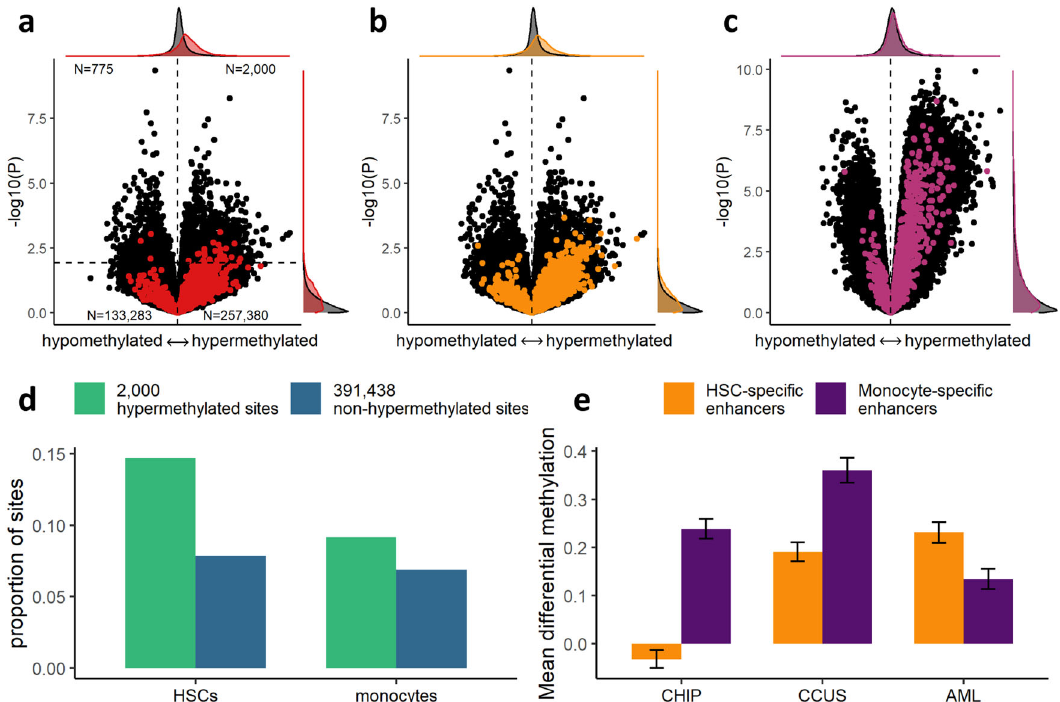
Fig. 5 TET2 mutation-associated hypermethylation in TCGA LAML data. a Results of epigenome-wide association studies in four and 86 AML patients with and without TET2 mutations, respectively. Red dots indicate CpG sites from the set of 2741 signi fi cantly hypermethylated sites in CHIP (Fig. 1c). Horizontal dashed line indicates P = 0.01. Margins display distributions of the 2741 sites versus the rest of the sites. Numbers in corners indicate the number of dots (both colors) in each quadrant separated by dashed lines. P values and effect size estimates derived using a linear model in Limma. P values are two-sided and not adjusted for multiple comparisons. b Similar to a . Orange dots indicate CpG sites from the set of 12,096 signi fi cantly hypermethylated sites in CCUS granulocytes. Only overlapping sites between the two sets are shown. P values and effect size estimates derived using a linear model in Limma. P values are two-sided and not adjusted for multiple comparisons. c Volcano plot of CCUS granulocyte results (same as in Fig. 3a) but with the 2000 signi fi cantly hypermethylated sites in AML highlighted (purple dots). P values and effect size estimates derived using a linear model in Limma. P values are two-sided and not adjusted for multiple comparisons. d Proportion of hypermethylated and non-hypermethylated sites in AML located in hematopoietic stem cell (HSC)-speci fi c ( N = 14,398) and monocyte-speci fi c enhancers ( N = 14,017). e Mean scaled effect size estimates of TET2 mutations at all CpG sites located in HSC-speci fi c ( N = 47,748) and monocyte-speci fi c enhancers ( N = 37,518). Error bars indicate 95% con fi dence intervals. See Supplementary Fig. 13 for plots of data